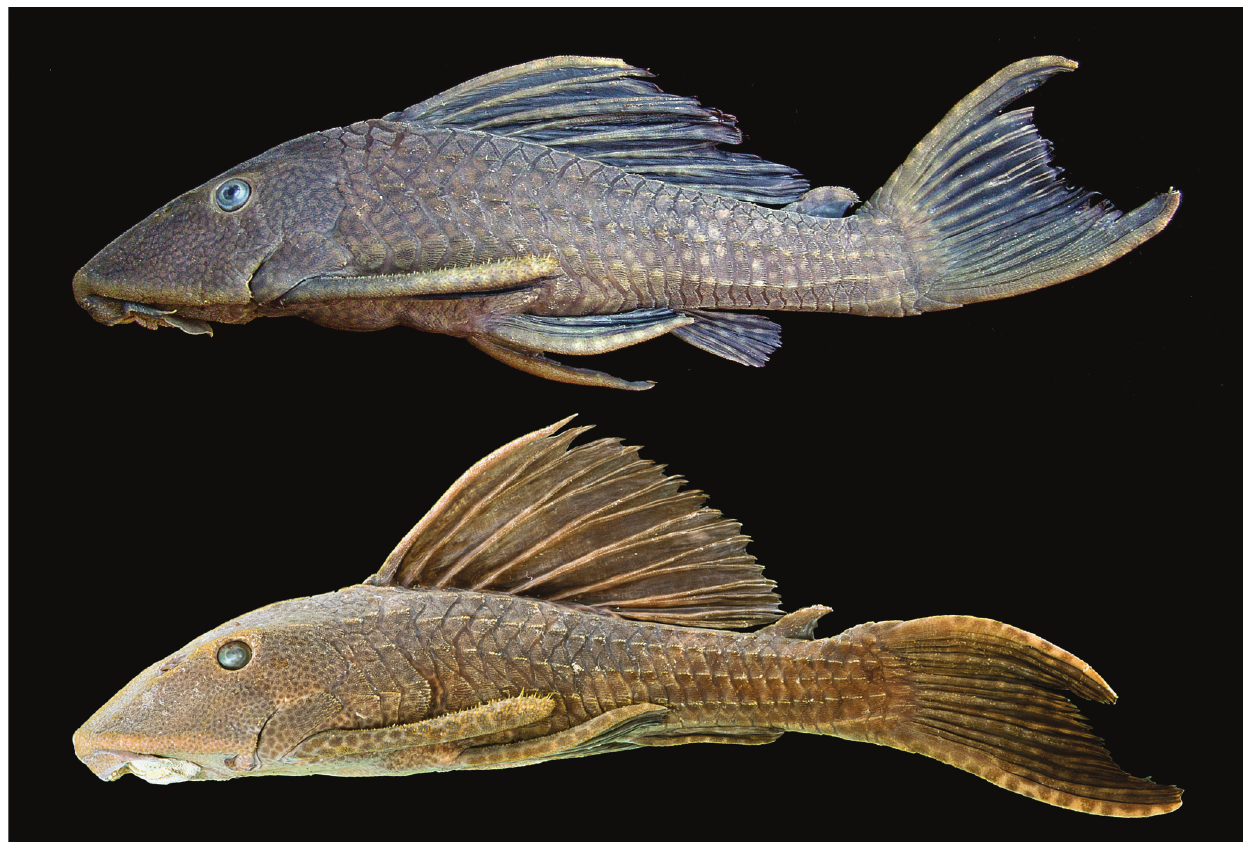
Fig. 5. Lateral view of preserved specimens of Hypostomus delimai NUP 11016, paratype, 176.7 mm SL (top); and H. hoplonites INPA 31849, 225.0 mm SL